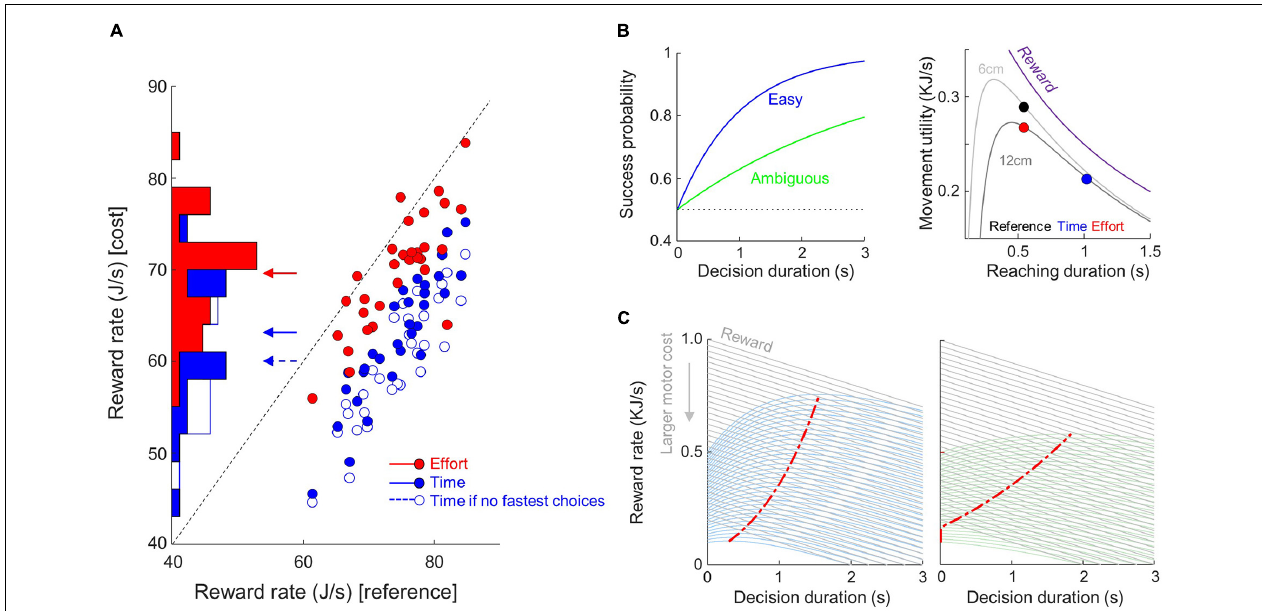
FIGURE 5 | Observed and theoretical effects of motor conditions on reward rate. (A) Distributions and comparisons of the average reward rate of each subject (dots) between costly conditions (ordinate, filled blue dots for Time, red for Effort) and the Reference condition (abscissa). Arrows mark the mean values for each condition. Unfilled blue dots show the rate of reward if subjects who shortened their decision durations in the Time condition compared to the Reference condition did not accomplish this shortening. (B) Left: Hypothetic success probability (SP) profiles of one easy (blue) and one ambiguous (green) trials. Right: Reward temporal discounting and movement utility according to movement duration (abscissa) and amplitude (see text for details). (C) Reward rate computed as the product between the reward value linearly discounted during decision duration (gray lines) and the SP ( B , left) in easy (left panel) and ambiguous (right) trials for various initial reward values. The initial value of reward is reduced as motor cost increases (downward gray arrow). The red dots mark the maximal value for each reward rate